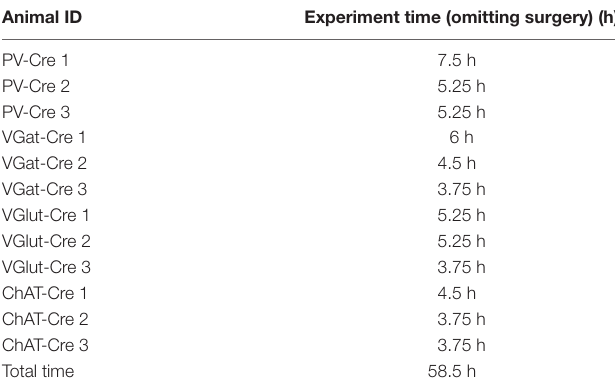
TABLE 2 | Duration of the anaesthetized MS surgeries assisted by